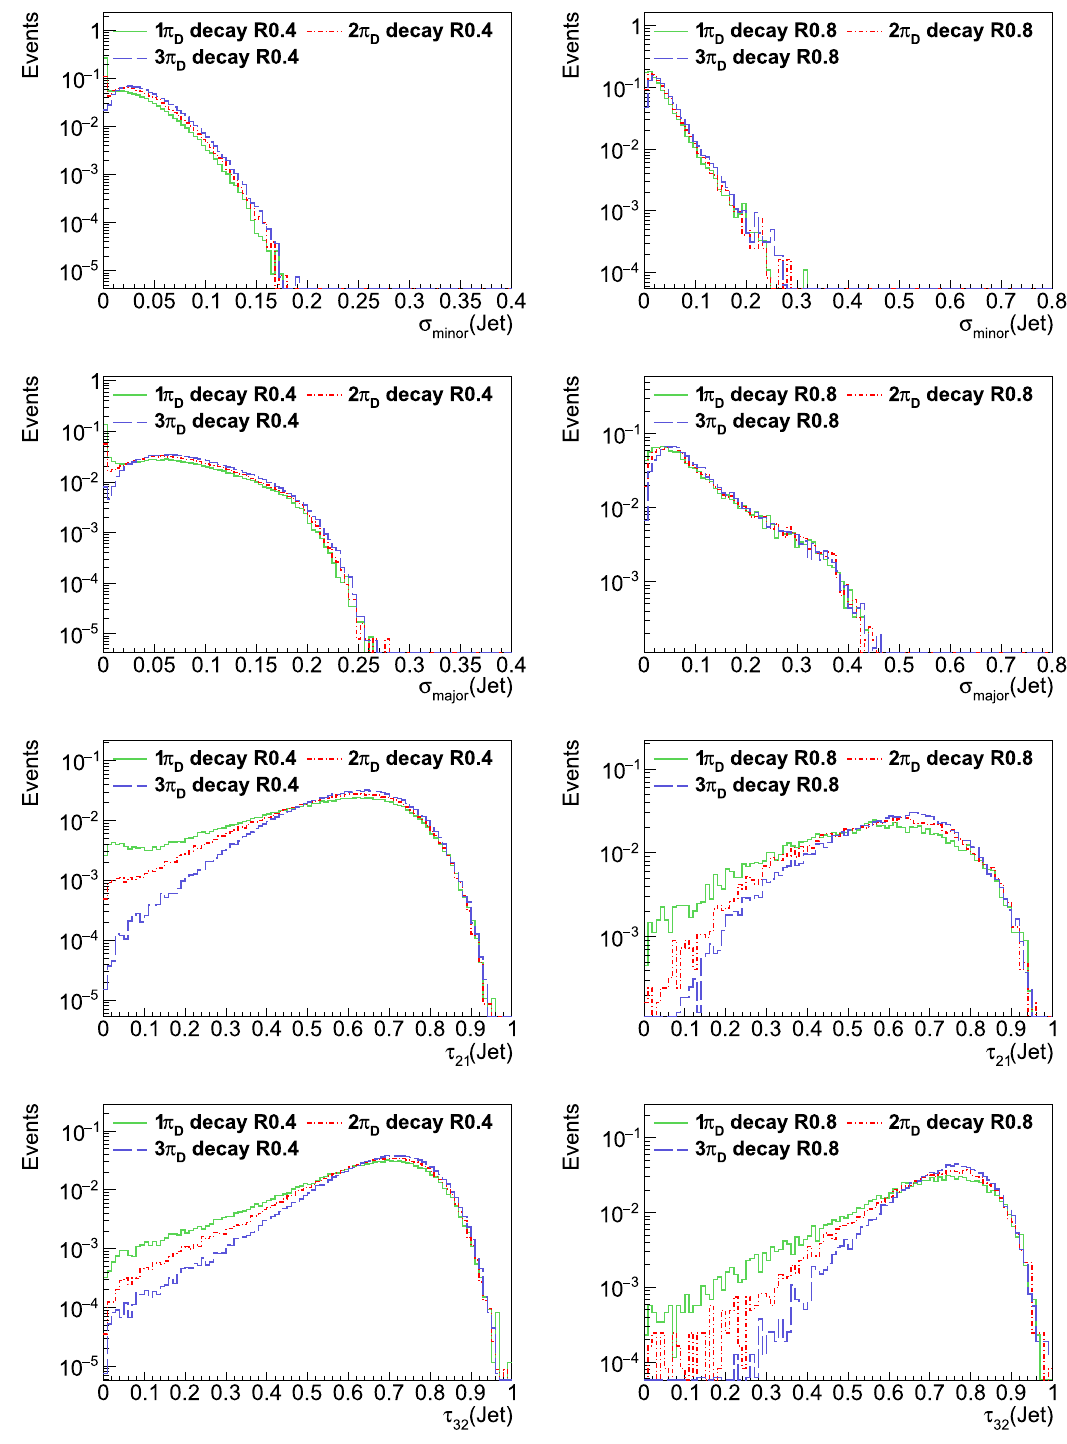
Fig. 49 Comparison of reco-level variables between different number of unstable diagonal dark pions for probVector=0.5 . Left column show the R = 0 . 4 jets and right column R = 0 . 8 jets. First row is the axis minor, second row is the axis major, third row is the n-subjettiness ratio τ 21 and fourth row is τ